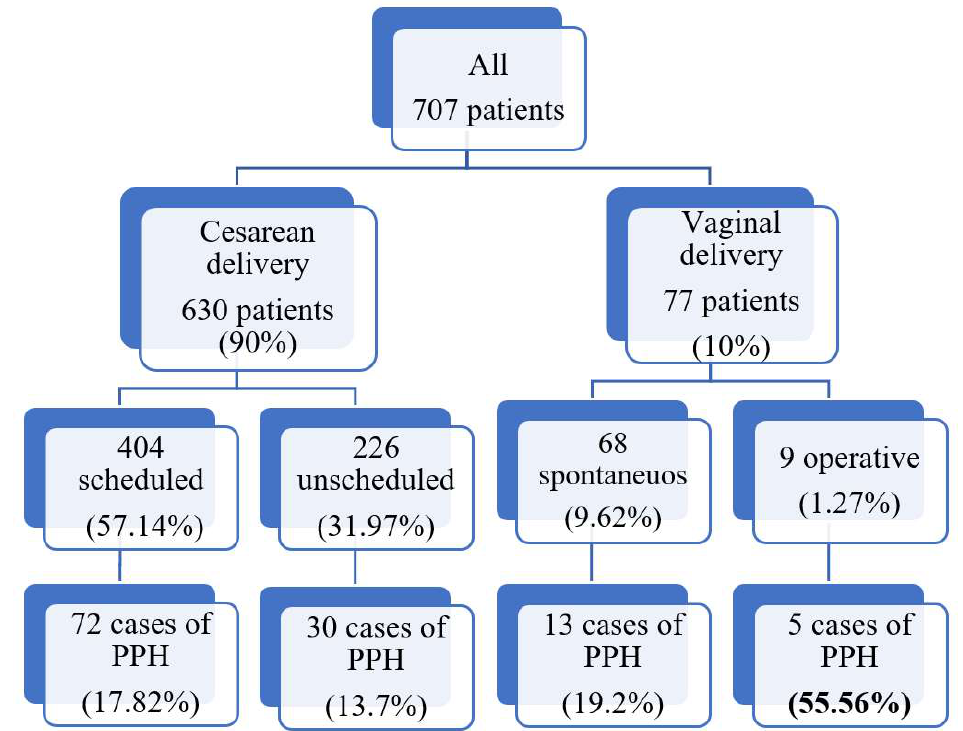
Figure 1. Association between PPH and mode of delivery.